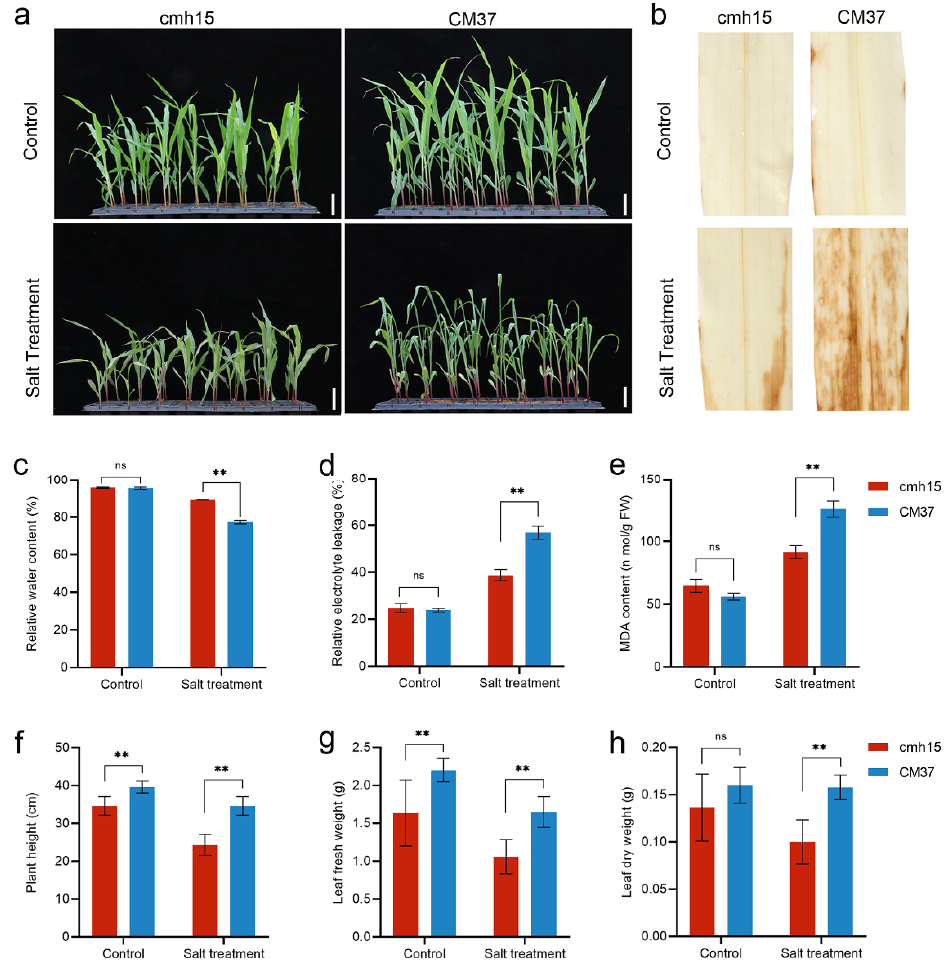
Figure 1. Phenotypic and physiological responses of cmh15 and CM37 seedlings under control and salt stress conditions. ( a ) Phenotypic response of cmh15 and CM37 seedlings. Scale bar = 5 cm. ( b ) DAB staining of CM37 and cmh15 leaves. ( c – e ) Relative water content, relative electrolyte leakage, and malondialdehyde content. ( f – h ) Plant height, leaf fresh weight, and leaf dry weight. Each bar represents at least three means ± SE. ** p ≤ 0.01; ns, not significant (calculated by t-test).